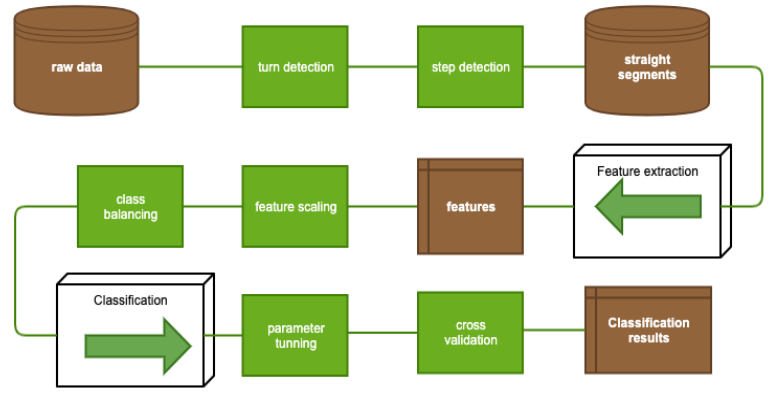
Figure 1. Flow diagram of data